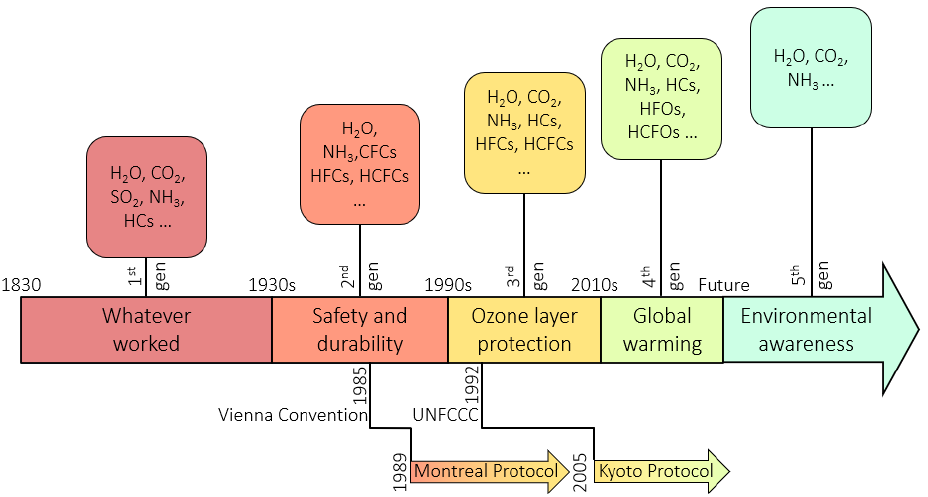
Figure 1. Historical development of refrigerants [17].